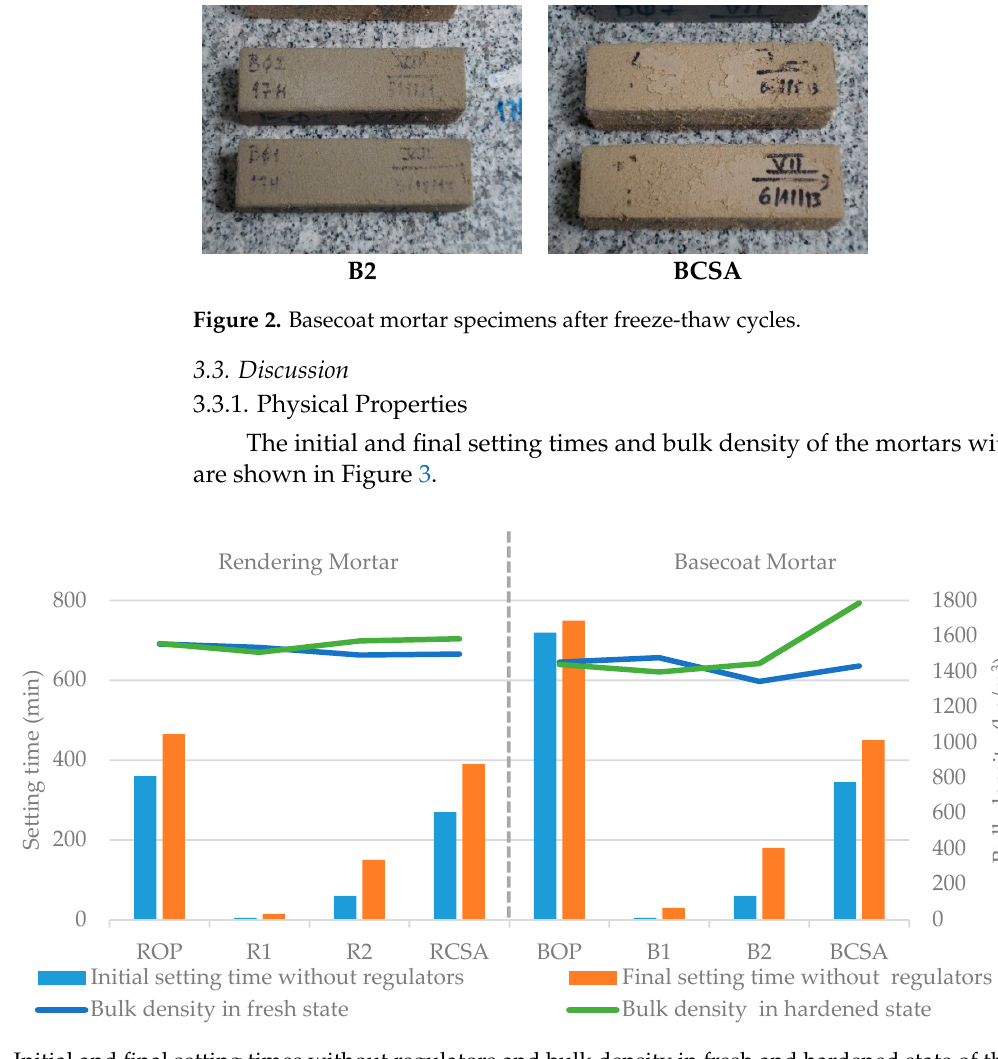
Figure 3. Initial and final setting times without regulators and bulk density in fresh and hardened state of the rendering and basecoat mortars.